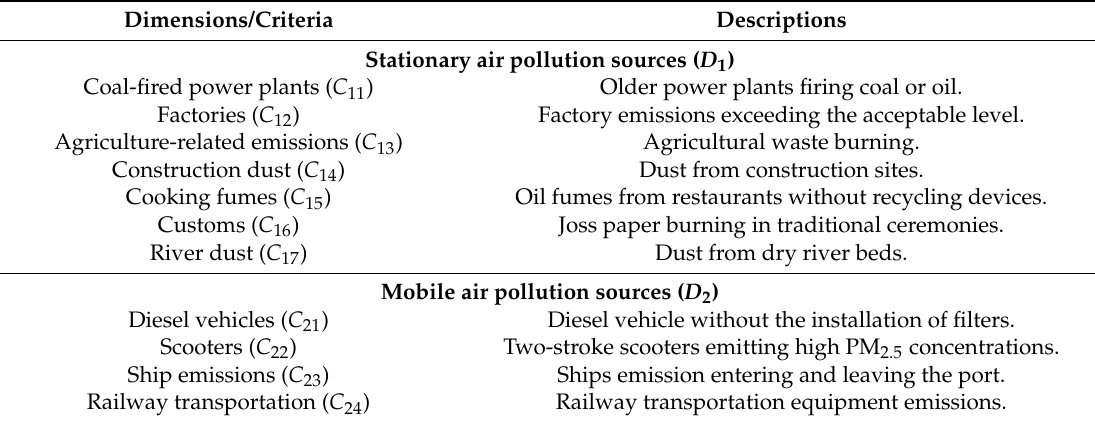
Table 1. Dimensions and criteria for evaluating air pollution